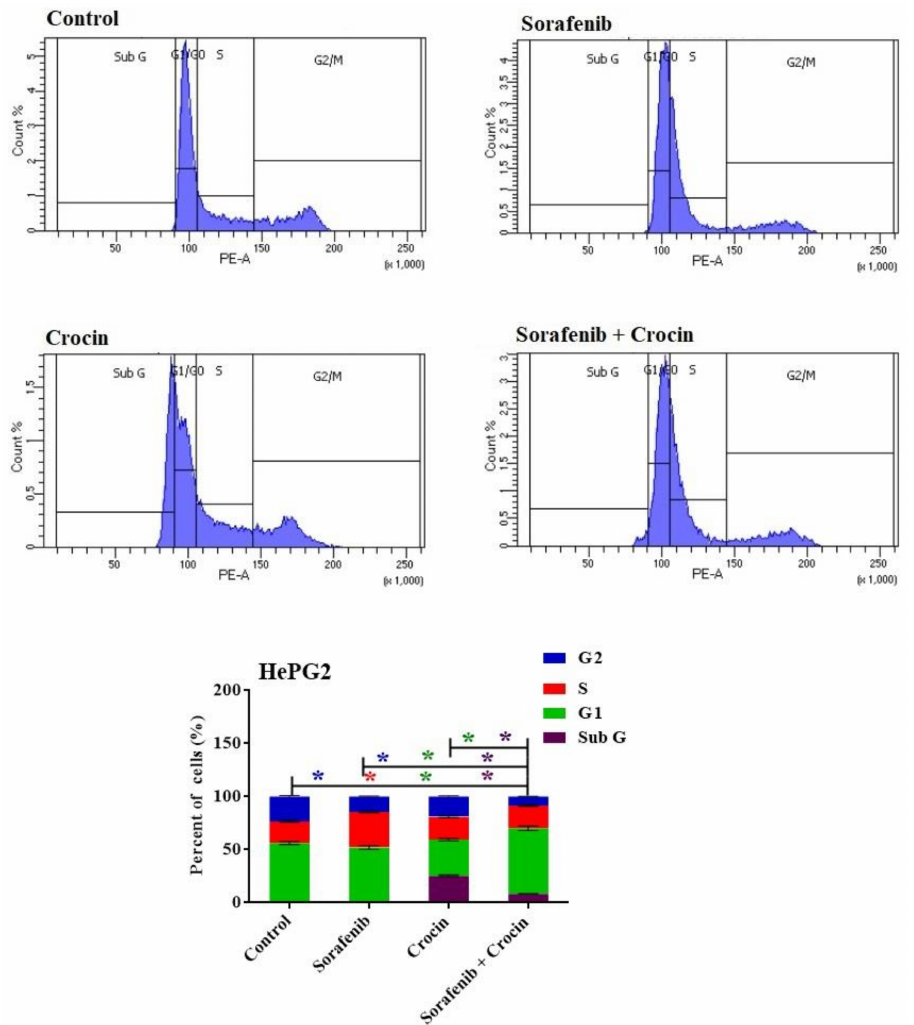
Figure 5. DNA cytometry analysis showing the effects of sorafenib and Crocin on cell cycle distribu- tion of HePG2 cells. Cells were exposed to sorafenib, crocin and the mix for 48 h. Cell phases were plotted as percentage of total events. Sub-G cell population was plotted as percent of total events of cells. Data were presented as mean ± SEM for three replicates ( n = 3). The differences of events from each respective control were considered significant at * p <